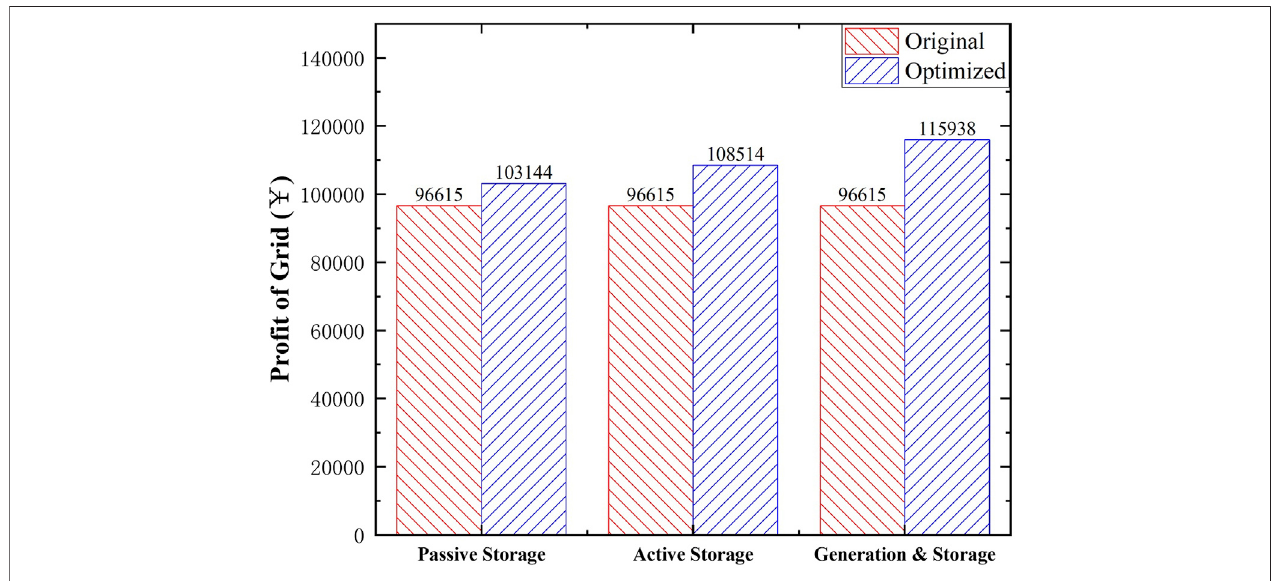
FIGURE 12 | Comprehensive grid income when interacting with buildings with different systems.